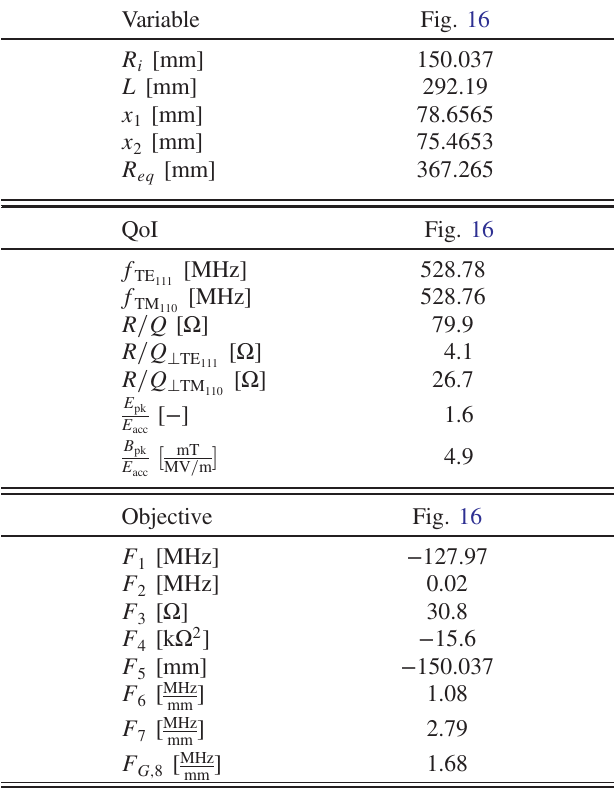
TABLE VIII. Design variable and objective function values, as well as QoIs, for the B´ezier cavity from Fig. 16. The frequency of 400 . 79 the FM is f FM ¼ is tuned FM